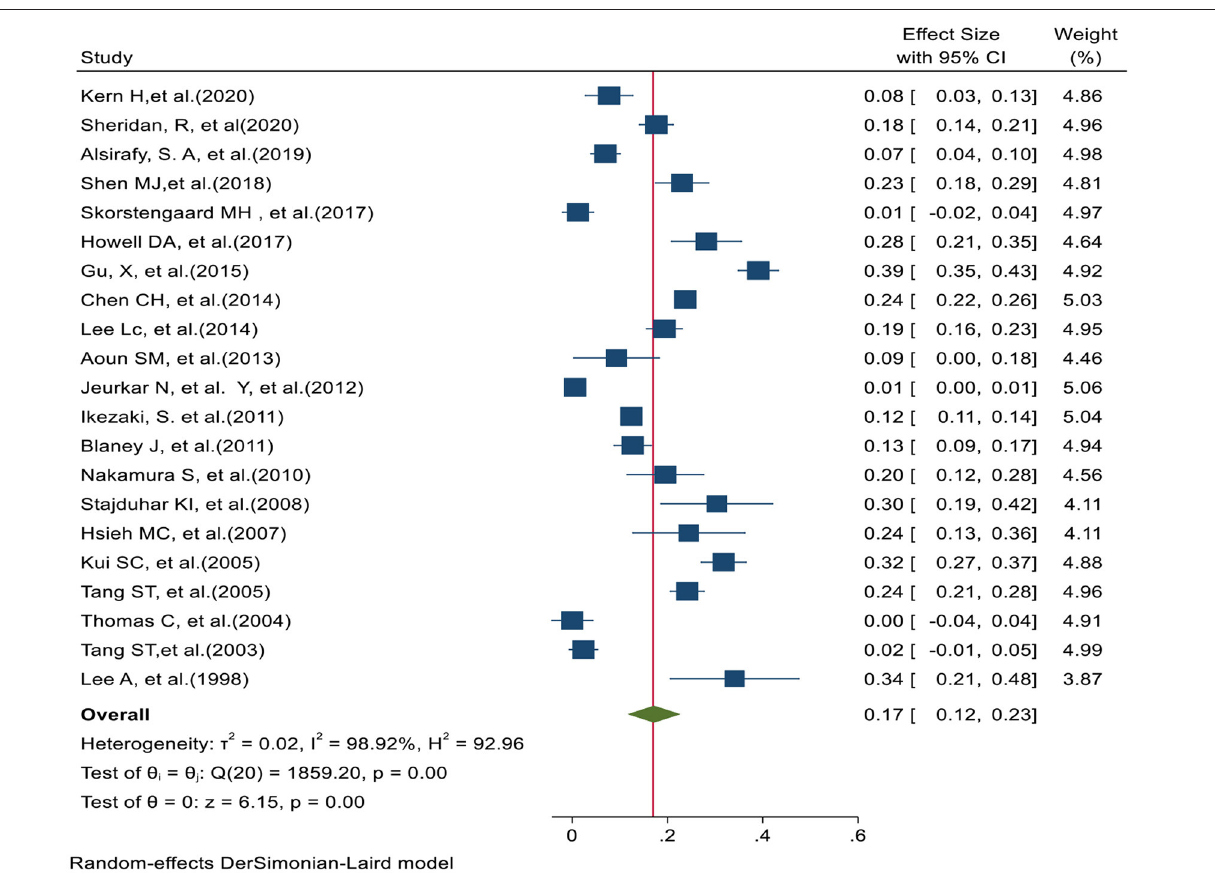
FIGURE 3 | Forest plot for the prevalence of Hospital-Based